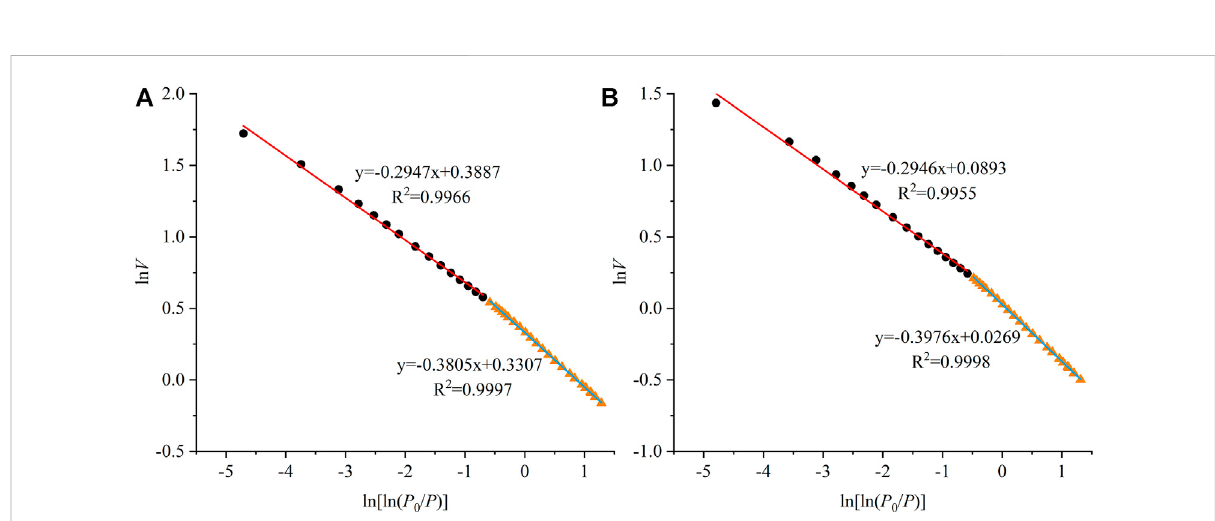
FIGURE 8 Scatter diagrams of ln V vs. ln[ln( P 0 / P )] for two typical shale samples, both with a demarcation point at P / P 0 = 0.5 (A) sample 2; (B) sample 4.